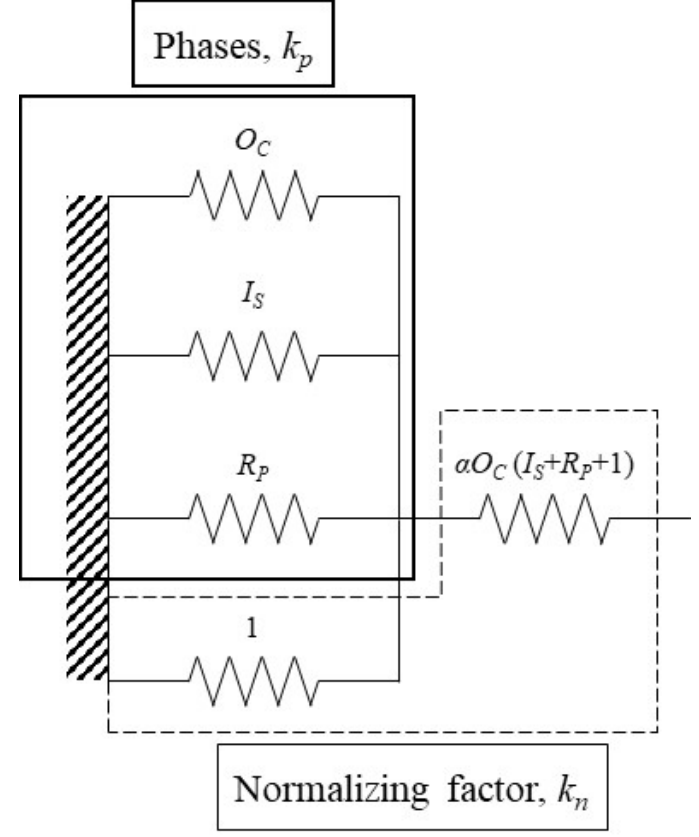
Figure 4. An ensemble of series and parallel springs as analogous to that of phases of the conceptual framework. The model has been proposed on the basis of onsite capacity ( O C ), instantaneous survivability ( I S ), and recovery potentiality ( R P ) of a given tsunami-prone area are homologous with the spring constants. The ensemble in Figure 4 has four parallel springs and one series spring. The e ff ective spring constant for parallel ensemble ( k p ) is given in Equation